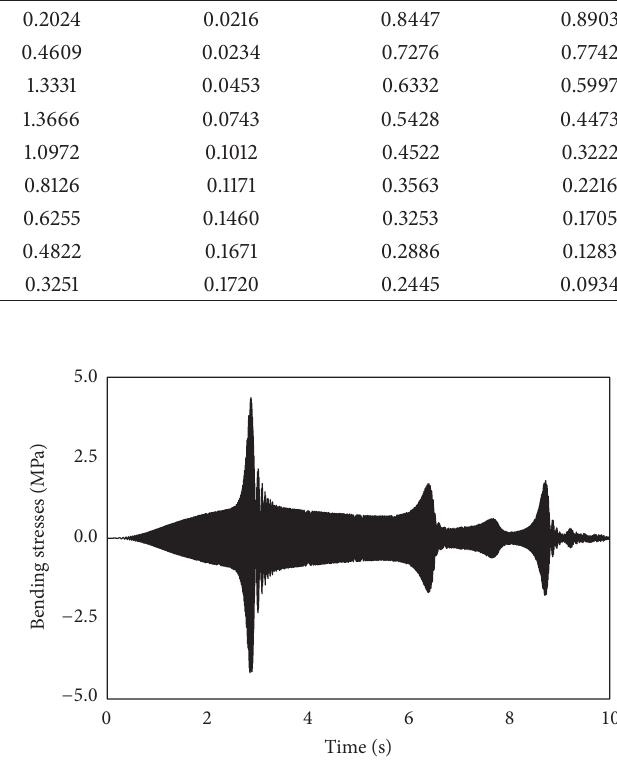
Figure 14: Alternating bending stresses evaluated at node 20 during the system transition through